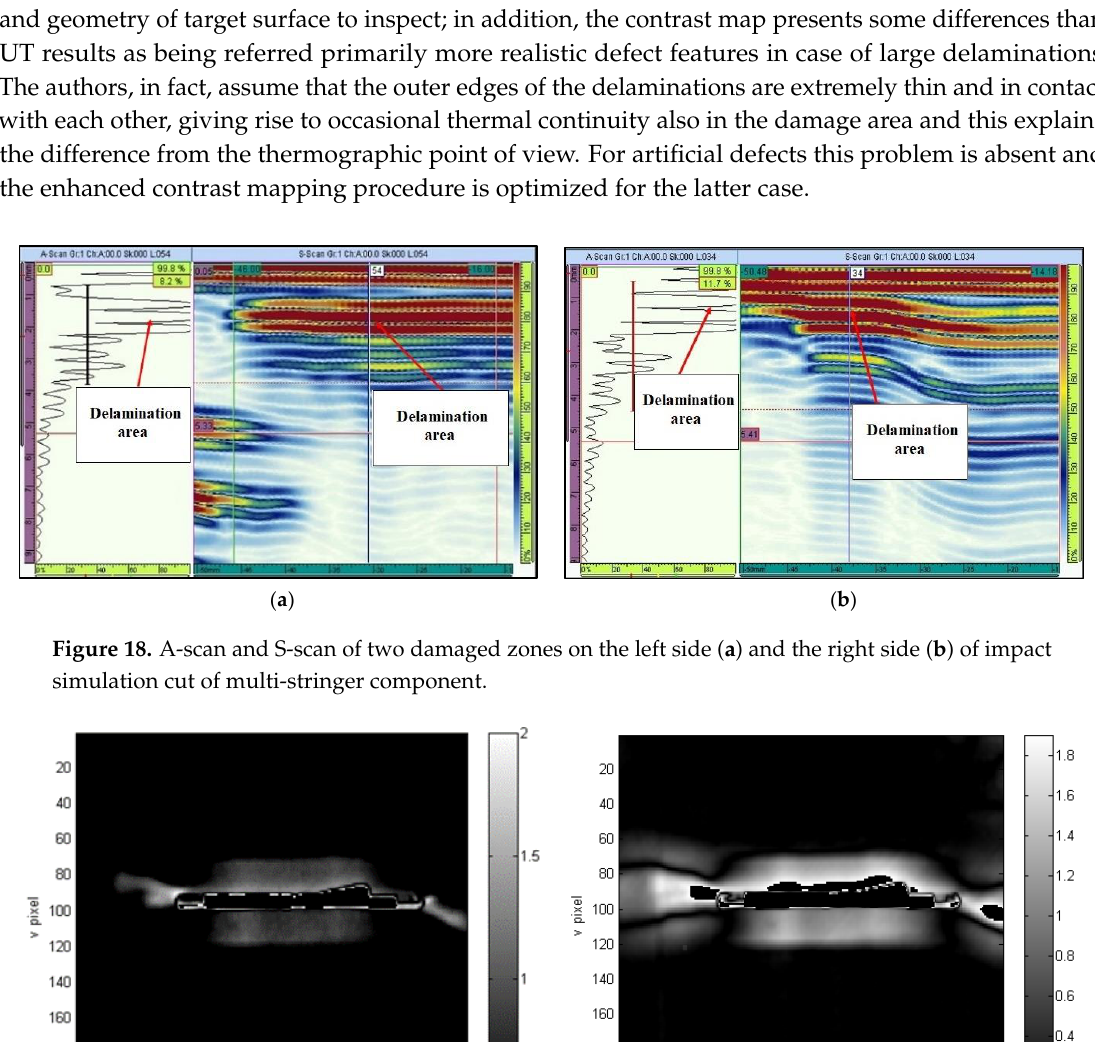
Figure 20. Contrast map of multi-stringer component using heating pulse of 7 s.